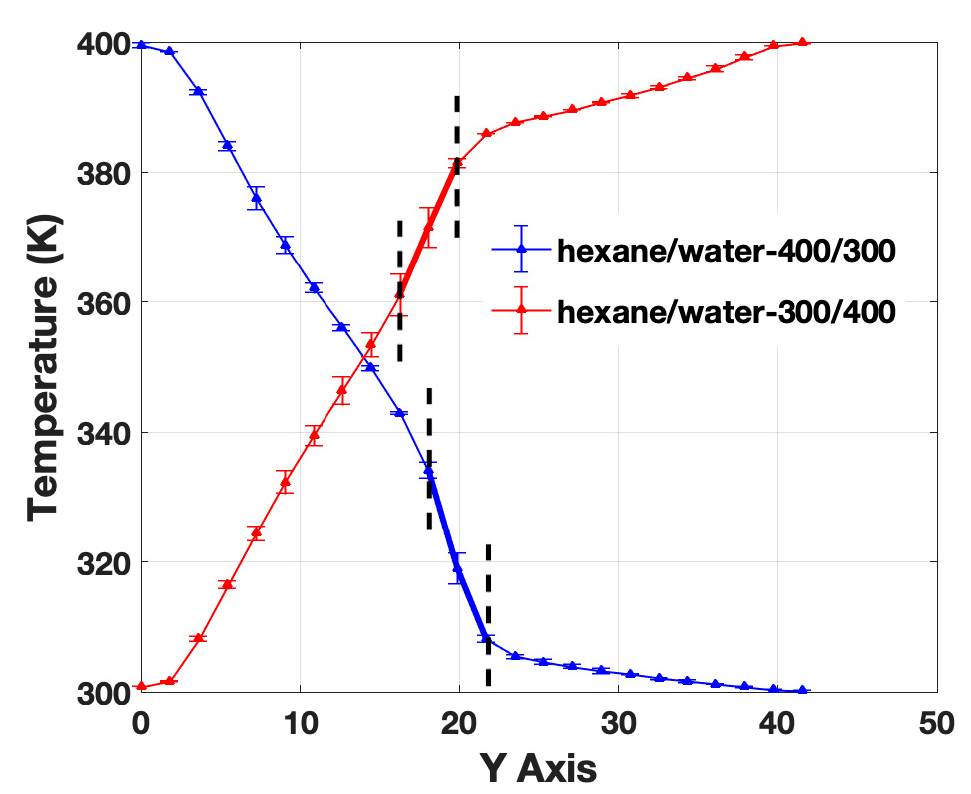
Figure 11. Temperature profiles of the case 7 (red) and case 8 (blue) in Table 3. Profiles are averaged, and only half is shown here because of the symmetry of system setups. Error bars are calculated when folding the data. Vertical lines cut out the interfaces, and they are plotted using thicker